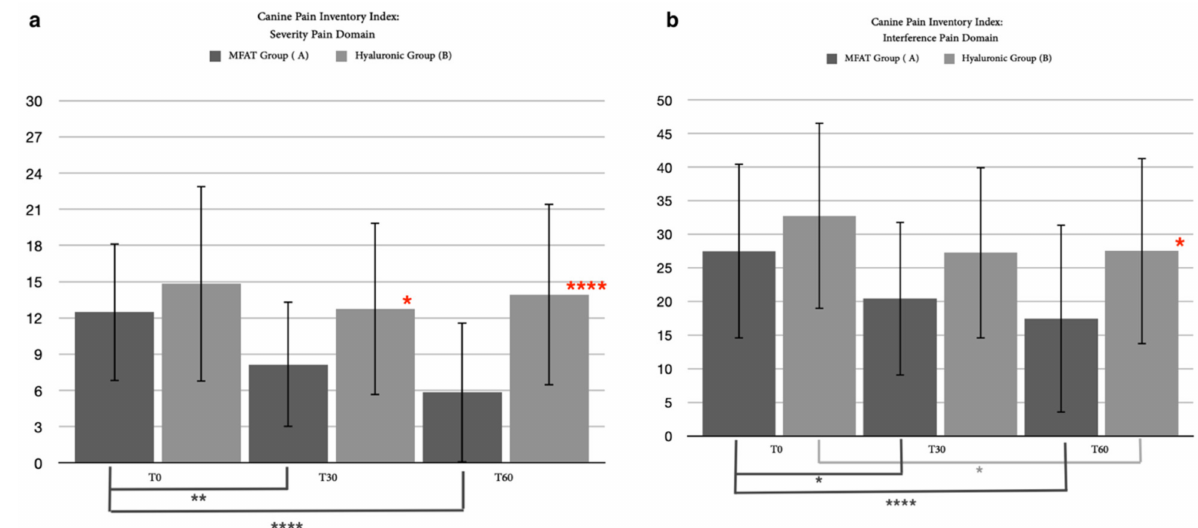
Figure 6. These graphs show the differences in statistical analysis data between Hyaluronic group and MFAT group for ( a ) CBPI pain severity after 30 days and after 60 days. Red asterisks (*: p = 0.0154; ****: p = 0.0133) indicate significant differences between groups, and group-colored asterisks indicate significant differences within each group ( **: p = 0.0094; * * ** : p < 0.0001); and ( b ) CBPI pain inter- ference after 30 days and after 60 days. Red asterisks ( * : p < 0.0001) indicate significant differences between groups, and group-colored asterisks indicate significant differences within each group (*: p = 0.0021; ****: p <